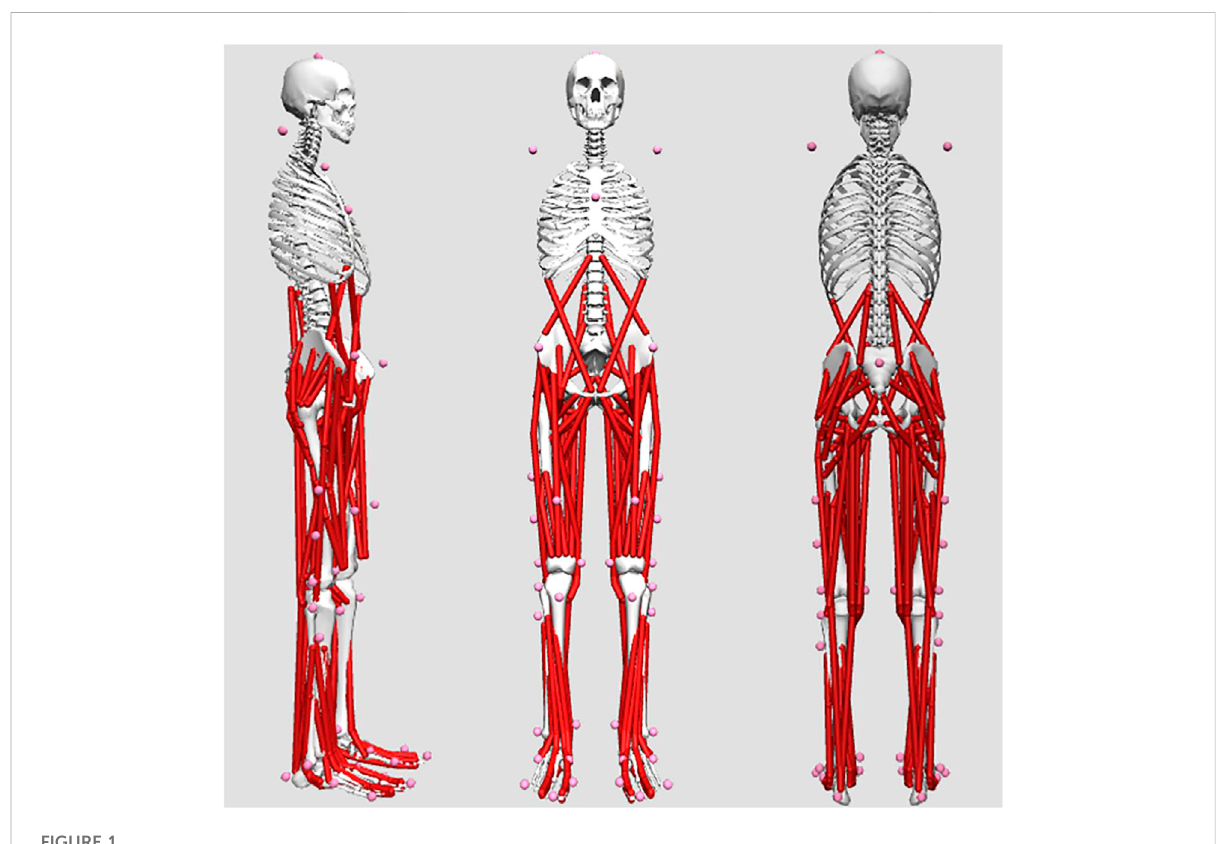
FIGURE 1 Illustration of the placements of the marker on three different